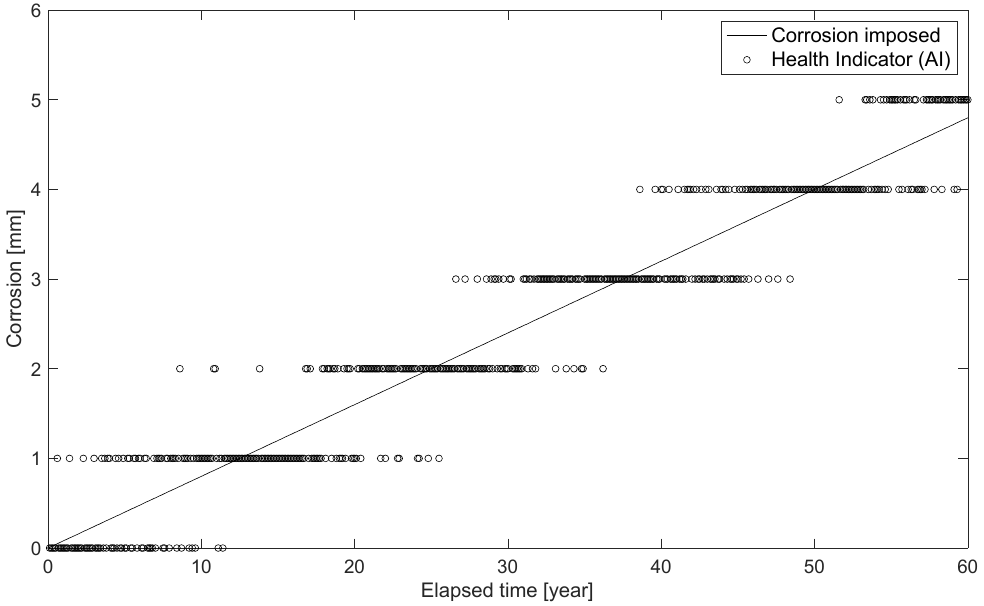
Figure 16. Damage estimation by AI as time passes.